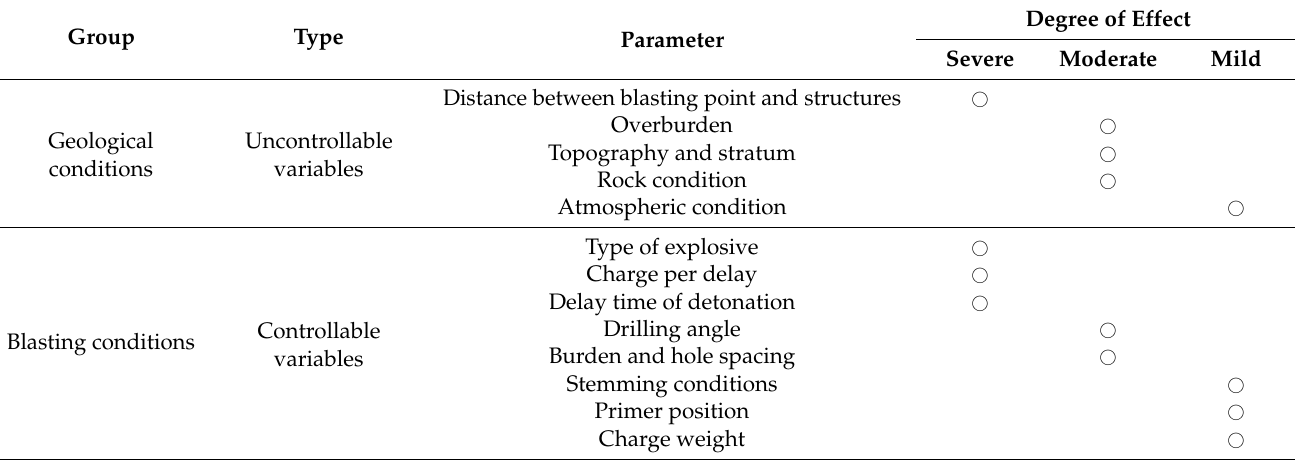
Table 6. Group of factors affecting blast-induced